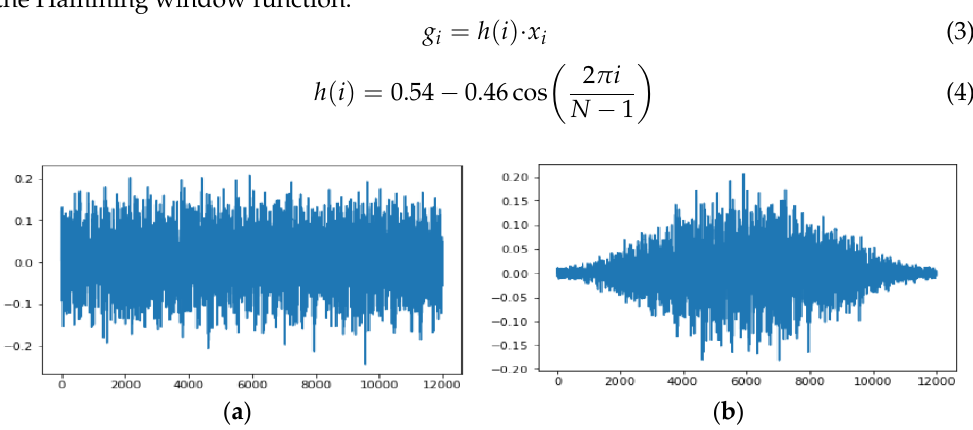
Figure 2. The vibration data ( a ) before and ( b ) after applying the Hamming window function.